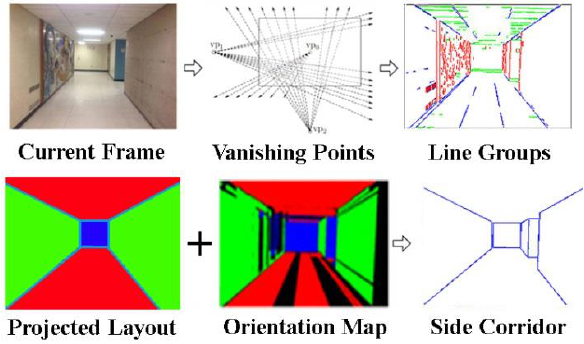
Figure 2. The orientation map of the projected scene layout compared to the current image orientation map to identify side